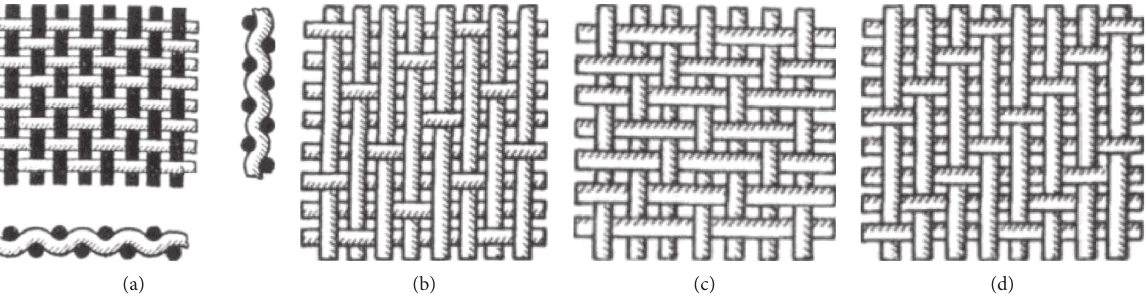
Figure 4: Some types of interlacing of glass fabrics [42]: (a) ‒ linen; (b) ‒ satin; ( s ) and (d) ‒ twill (fabrics of type 1/2 and 3/1).